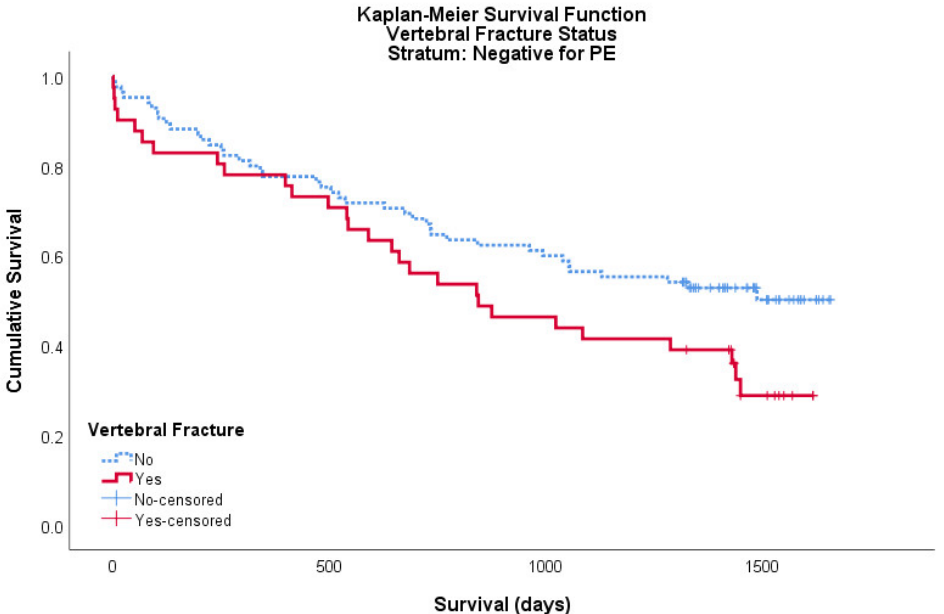
Figure 3. Kaplan–Meier survival curve showing the cumulative survival of patients with (red/solid) and without (blue/broken) a vertebral fracture on CTPA for patients negative for PE. Censored data is shown as ‘+’ in its respective colour.